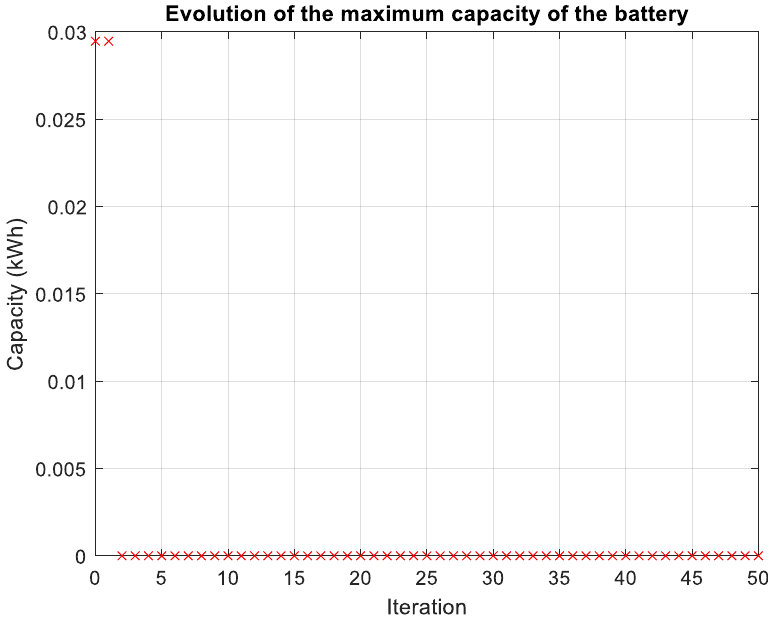
Figure 5. Obtained optimal capacity (kWh) along the PSO optimizer iterations.